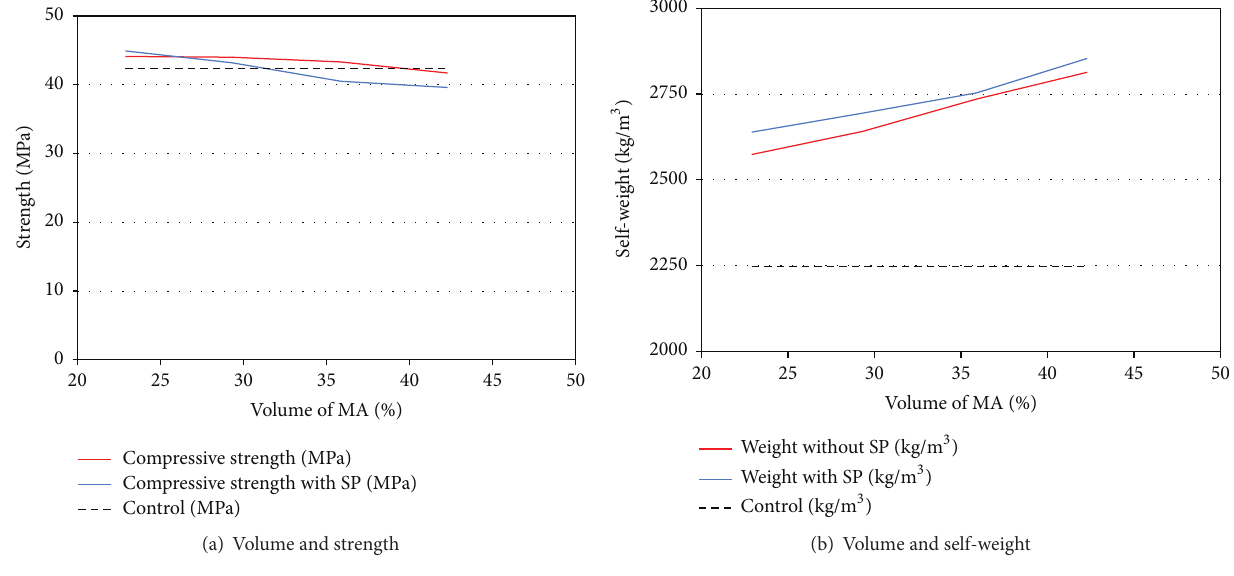
Figure 5: Changes in physical performance with varying MA replacement ratios.